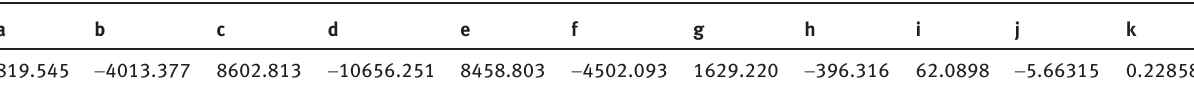
Table 2: Fit results of a of BR1500HS